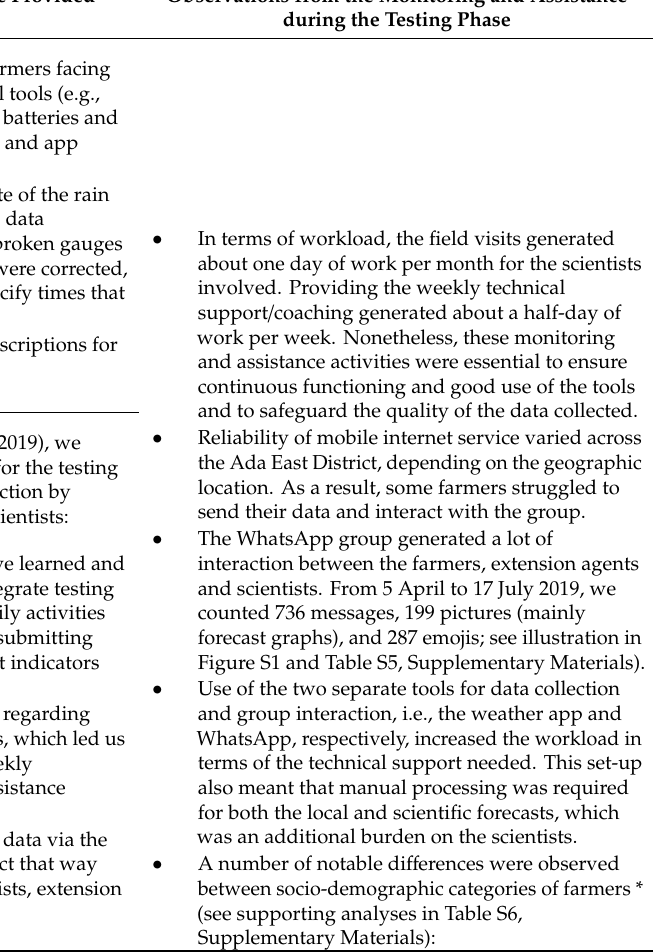
Table 4. Observations from the monitoring and assistance activities during the testing phase (April–July 2019).